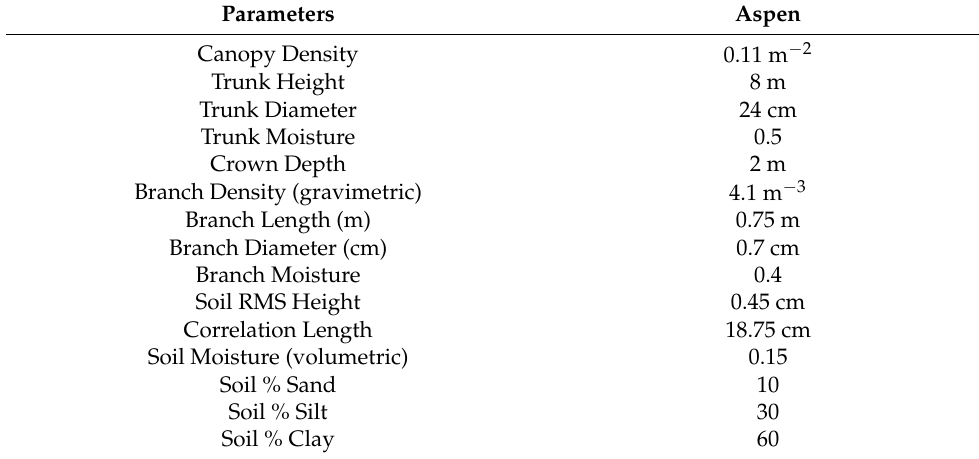
Table 1. Input parameters of Aspen.